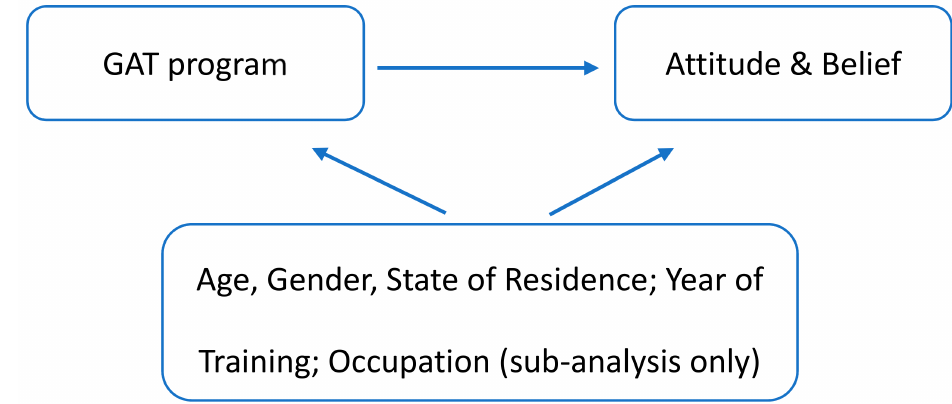
Figure 1. Directed acyclic graph guiding variable